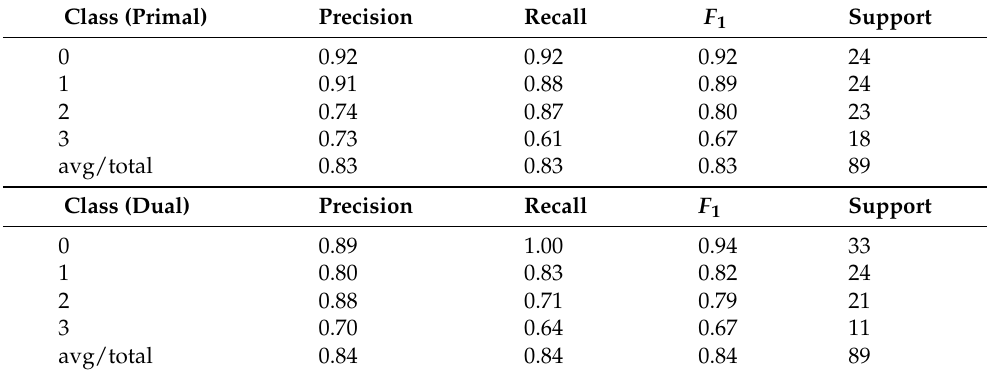
Table 10. Classification reports for the primal and dual simplex algorithm execution